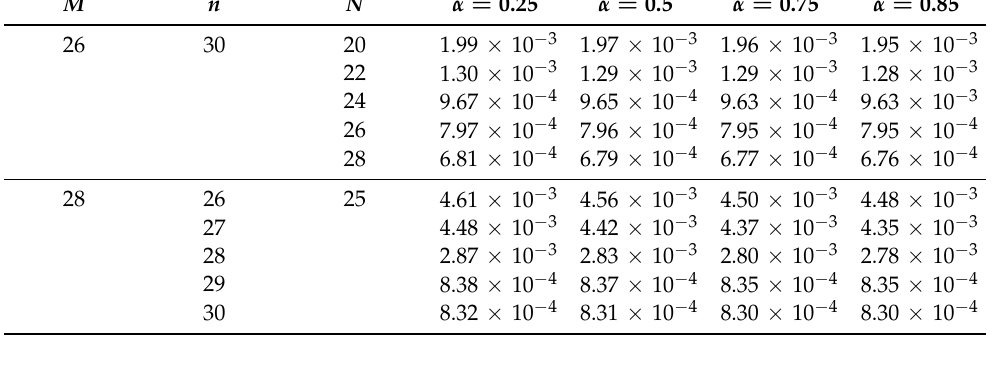
Table 4. The L ∞ error for different fractional orders α of problem 3. M